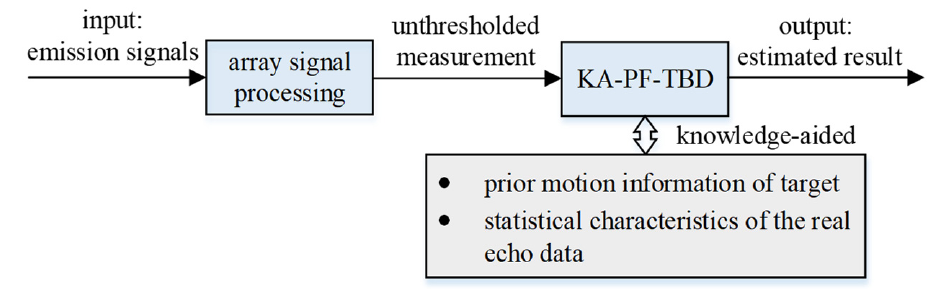
Figure 1. The KA-PF-TBD signal processing procedure flowchart.